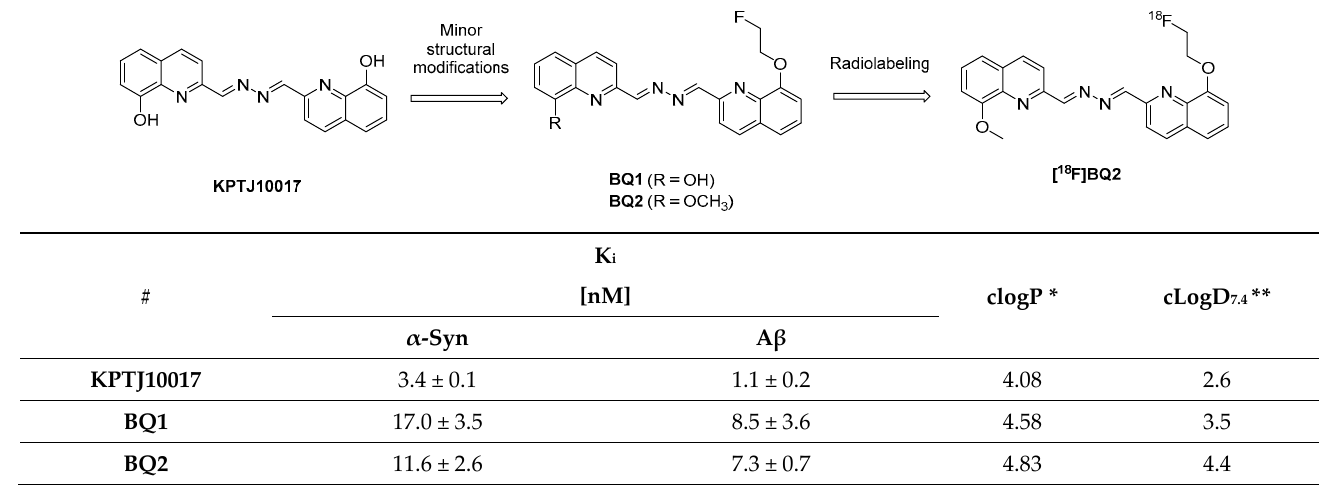
Figure 33. Chemical structure of KPTJ10017 , BQ1 , BQ2 , and [ 18 F]BQ2 with binding affinities (K i values) for recombinant α -syn and A β aggregates [120].* clogP values were calculated by BioByte. ** clogD 7.4 values calculated by ACD/Percepta.